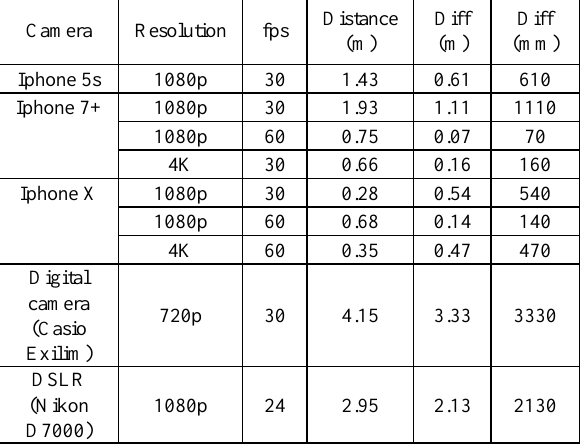
Table 4. Difference distance in z-axis